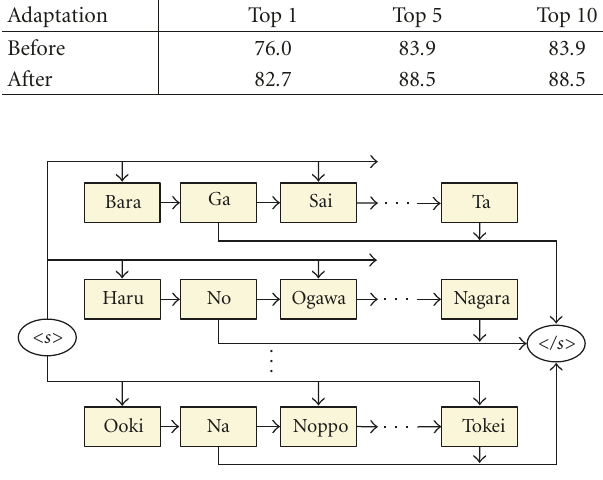
Figure 3: Example of improved